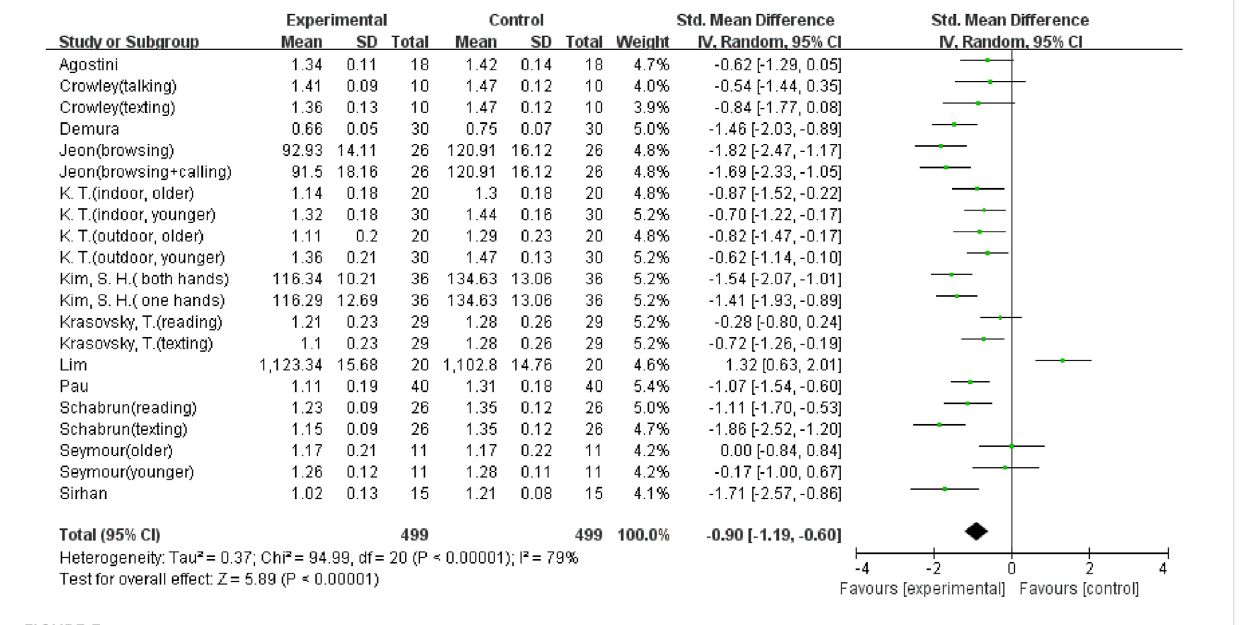
FIGURE 3 The effect of mobile phone use on stride